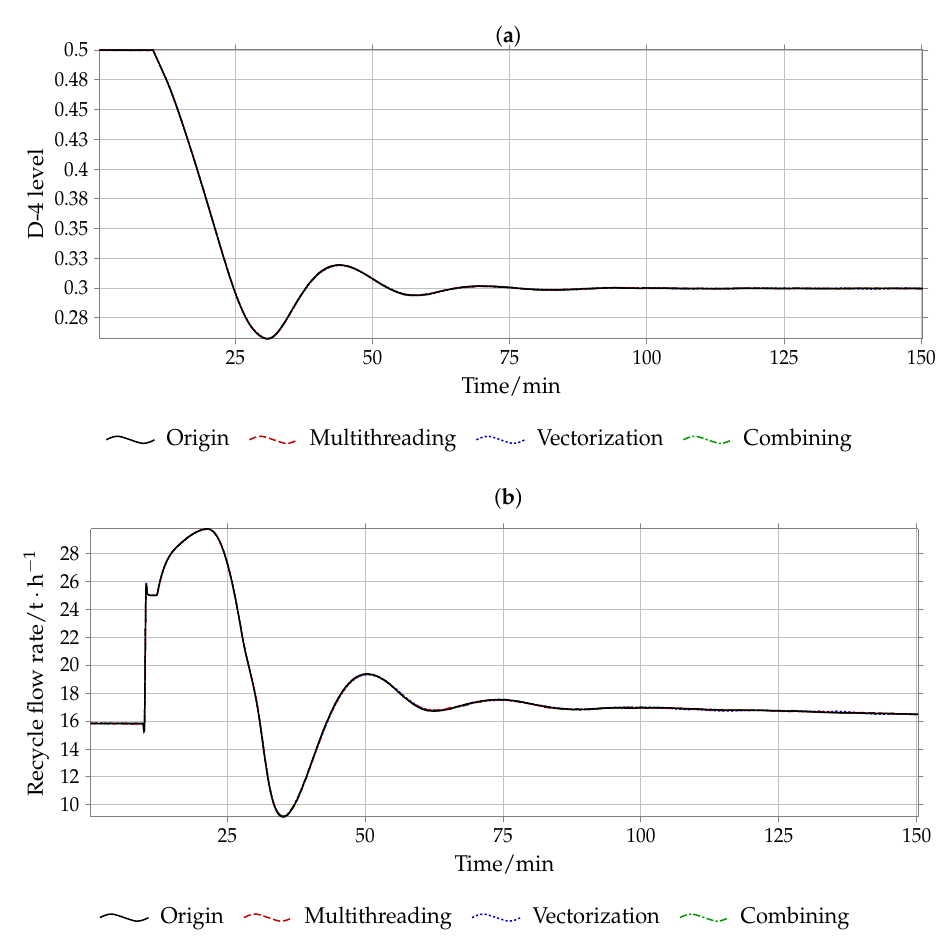
Figure 12. The simulation result with different acceleration methods. (a) D-4 level. (b) Recycle flow rate.